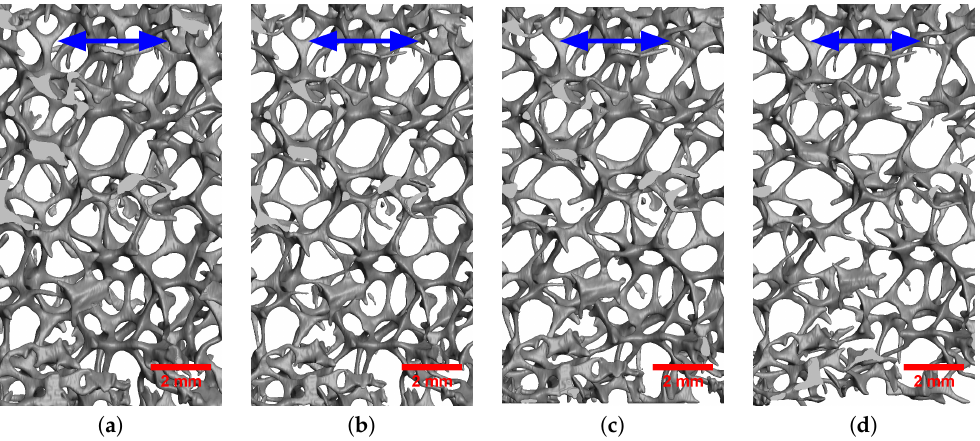
Figure 8. Deformation of the 30 PPI foam sample during the in situ tensile test at nominal strain: ( a ) 0.000; ( b ) 0.031; ( c ) 0.085; ( d ) 0.142. The blue arrow indicates the loading